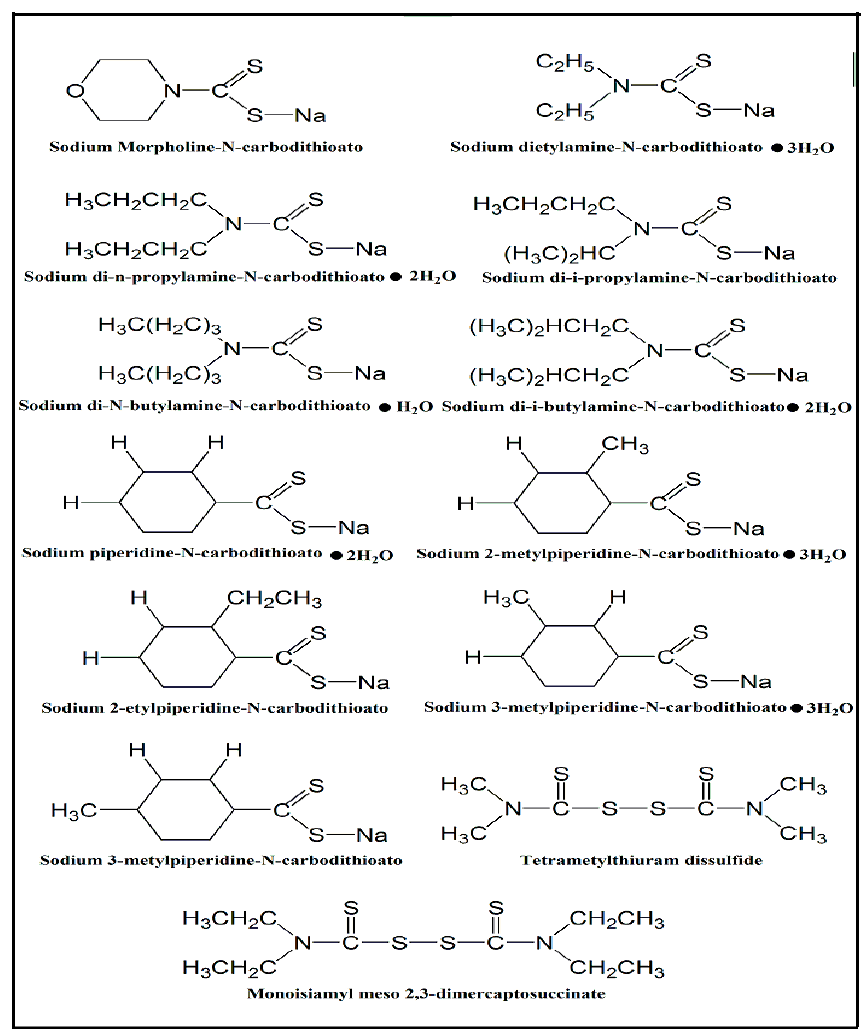
Figure 2. Compounds based on dithiocarbamate used as potential anti- Trypanosoma cruzi drugs. The figure represents the different structures of dithiocarbamates that showed antiparasitic activity. These compounds showed antiparasitic activity at a concentration of 5 µM during 72 h of treatment against the T. cruzi parasite. Increased production of reactive oxygen species seems to be the probable mechanism of action for these compounds to exhibit antiparasitic activity [26].